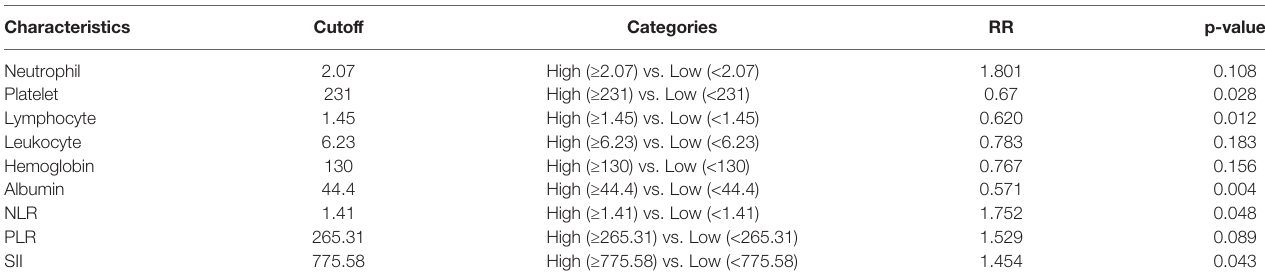
TABLE 2 | Univariate Cox analyses for OS of in fl ammation-related factors in the training group.